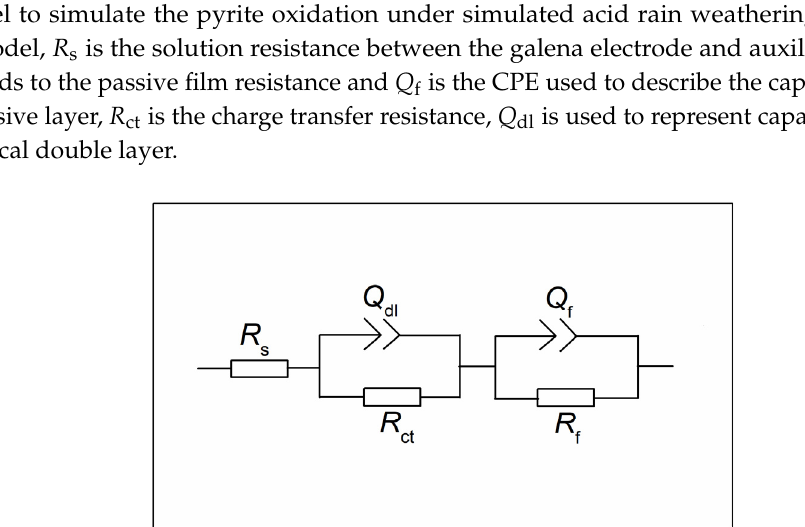
Table 3. Fitted impedance parameters for galena in NaCl solutions with different concentrations.